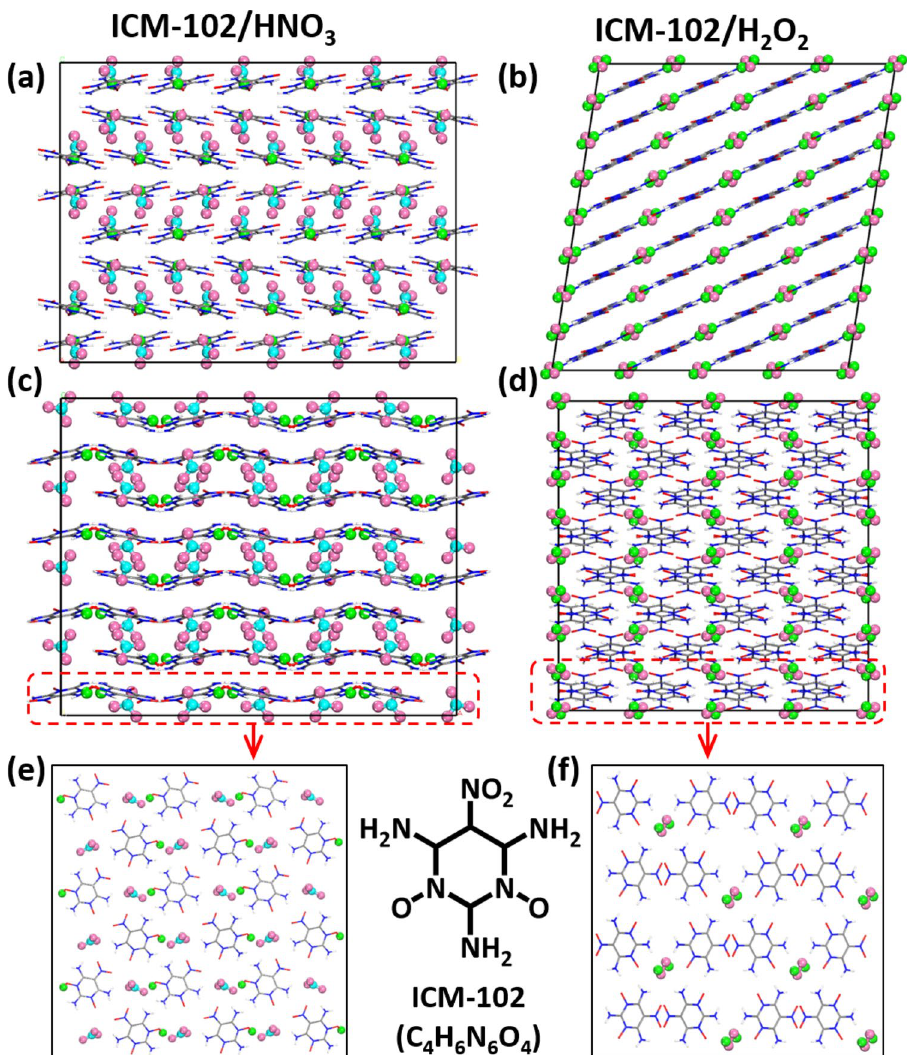
Figure 1. Initial unit cell structures. The ( a ) and ( b ) is a point of view from a-axis, ( c ) and ( d ) a point of view from b-axis, ( e ) and ( f ) is one layer of view from c-axis. The C, H, N, and O atoms of the host ICM-102 molecules are gray, white, blue, and red, respectively. The H, N, and O atoms of the guest molecules are green, cyan, and pink, respectively. The same representations will be used hereafter.